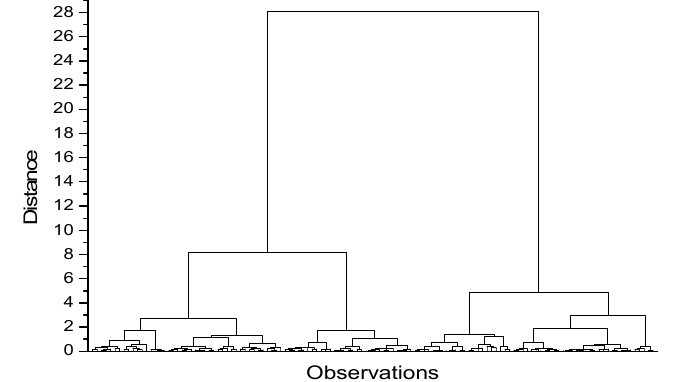
Figure 2. Dendrogram of precipitation grouping using the Ward method for Wroc ł aw [5].